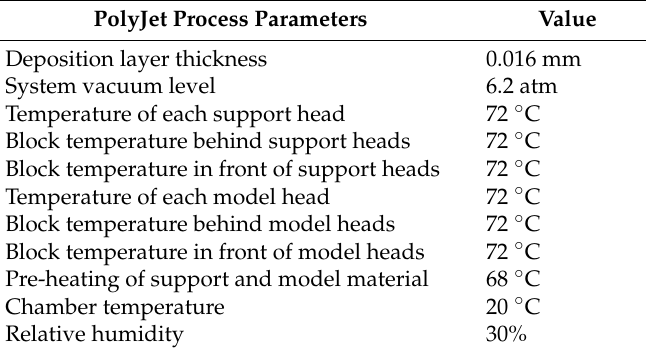
Table 3. Working conditions of EDEN 350